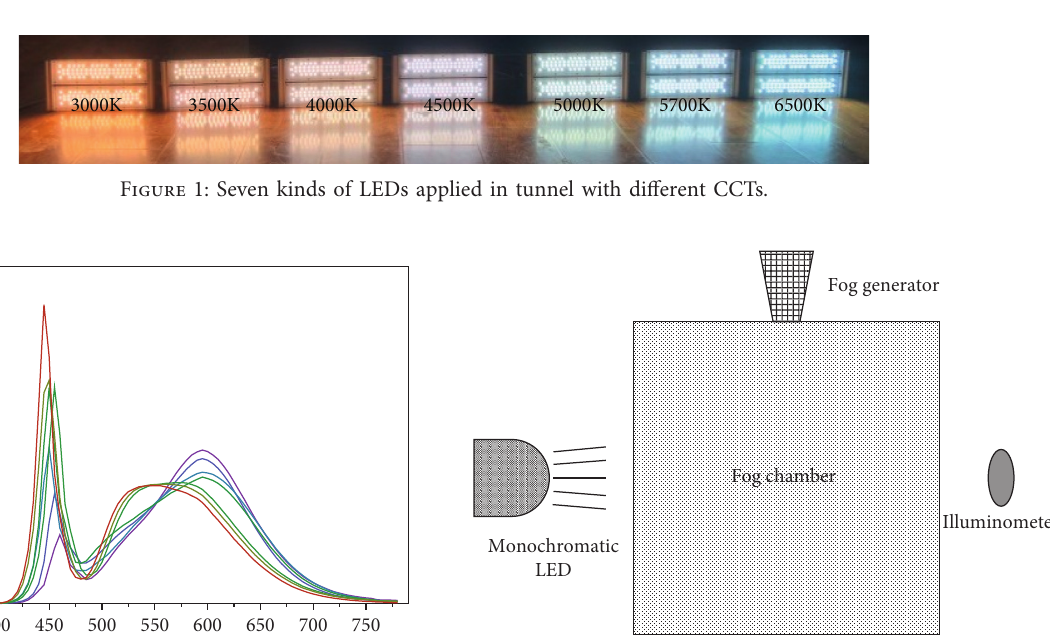
Figure 4: The schematic diagram of experimental